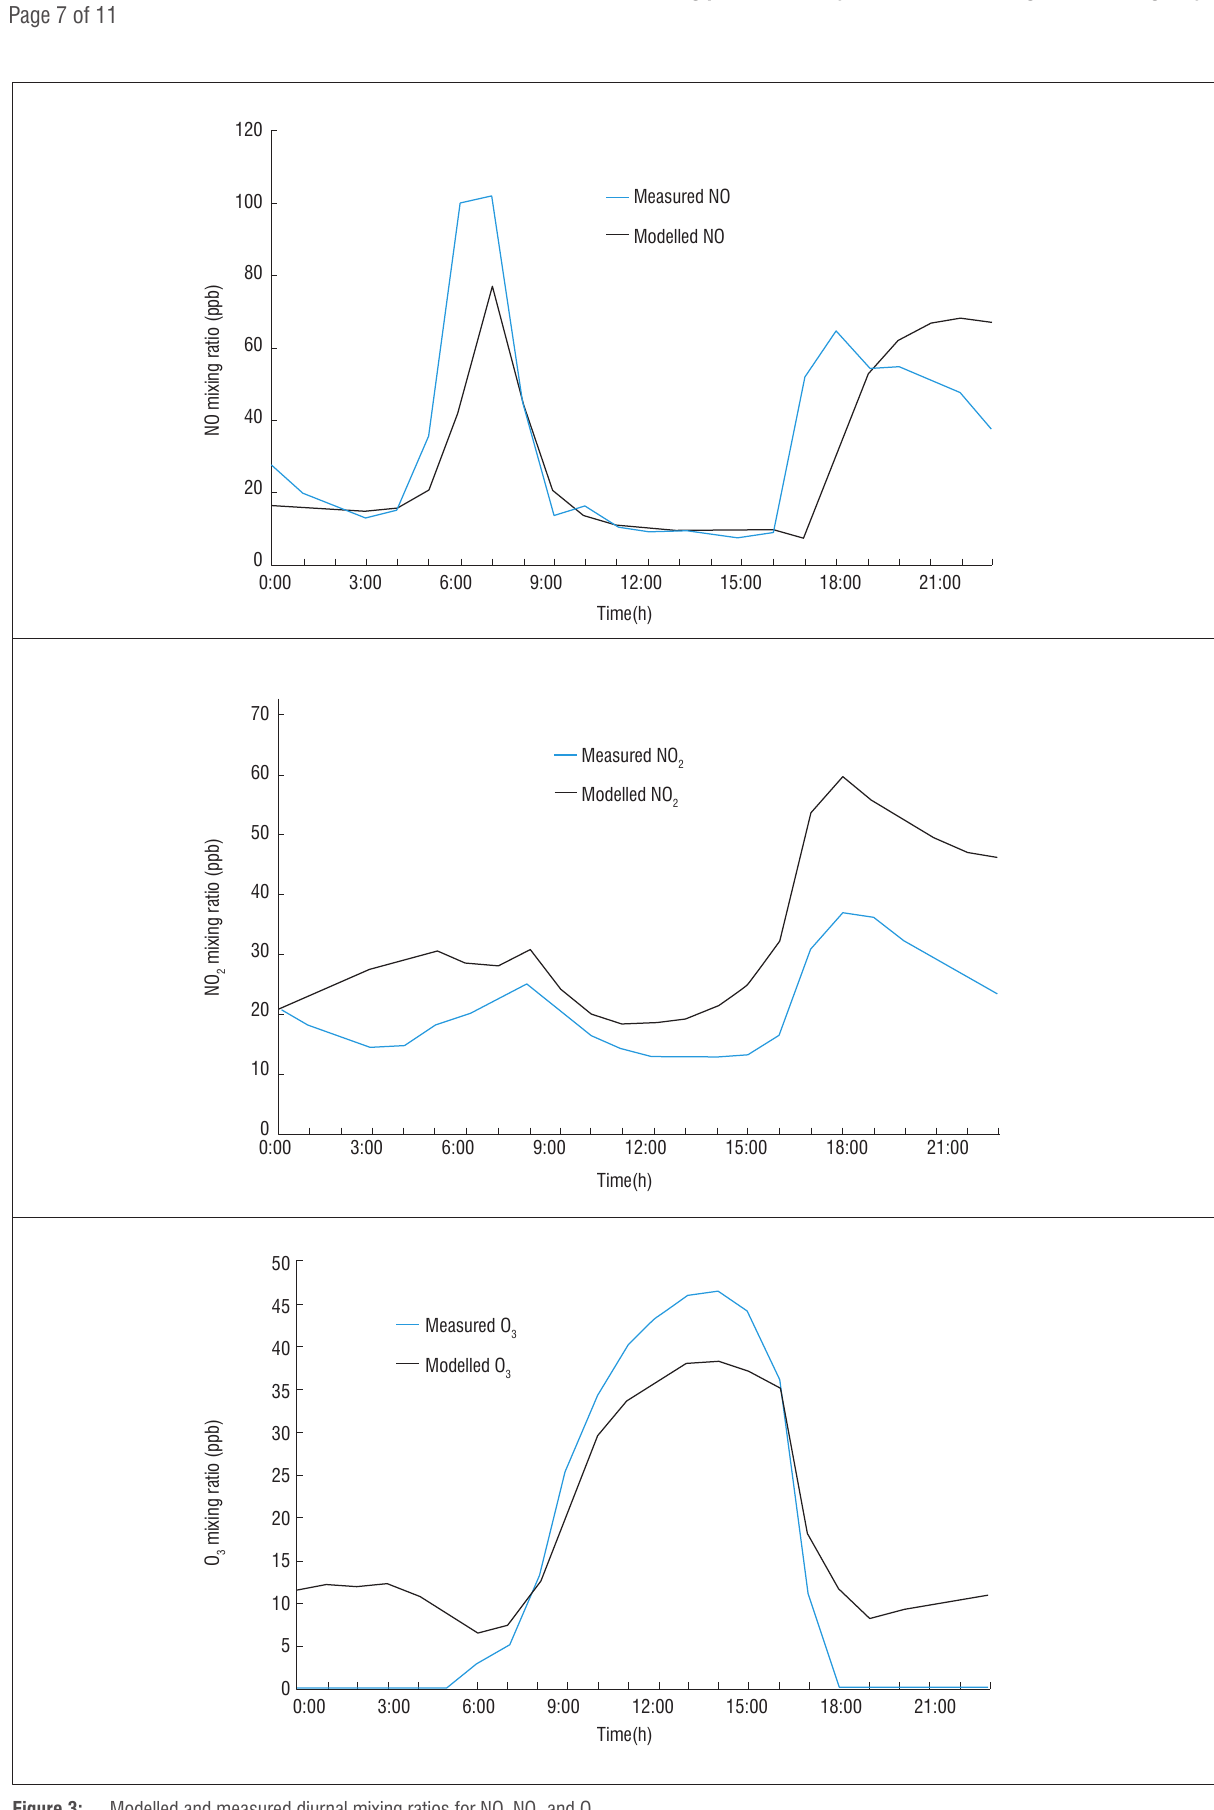
Figure 3: Modelled and measured diurnal mixing ratios for NO, NO